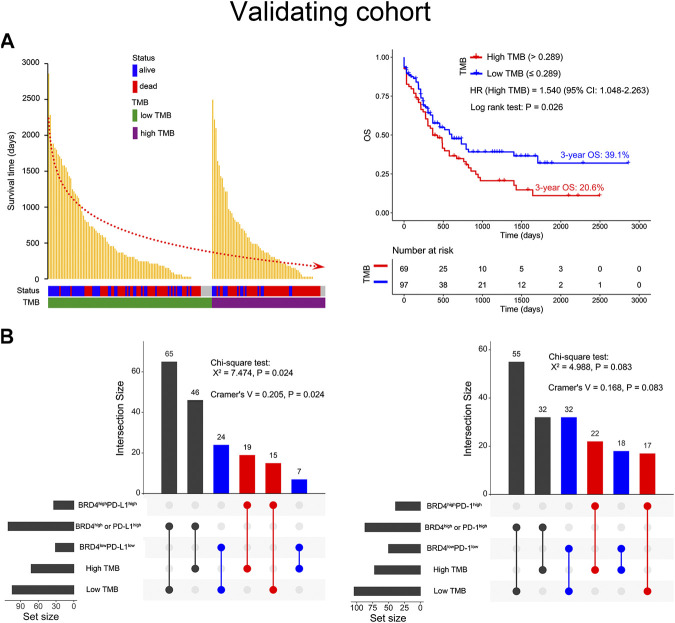
Relationship between BRD4, the PD-L1 or PD-1 combination, and tumor mutation burden (TMB) in the validating cohort. (A) The survival time distribution (left panel) and survival curves (right panel) depicted based on the TMB status of the AML patients. The red dotted line represents the trend in survival time with the change in TMB status. (B) The Chi-square test used to evaluate the correlation between BRD4 and PD-L1 or PD-1 co-expression and TMB status. The Cramer’s V value ranged from −1 to 1 where the higher values represent a stronger correlation. The connections indicate an intersection of two variables.